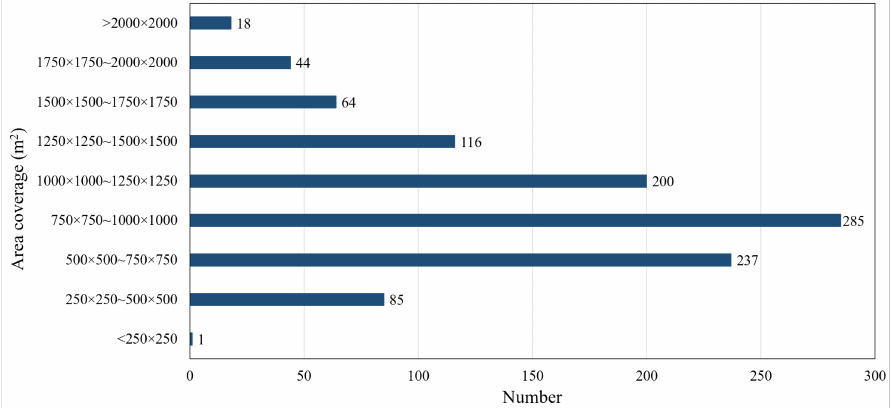
Figure 8. Size distribution of the minimum bounding squares of the collected road junction samples.